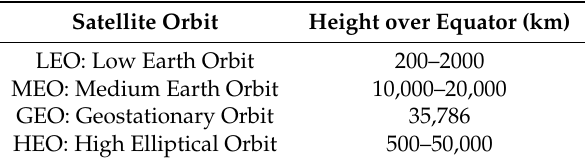
Table 4. Overview of satellite communication orbits and characteristics